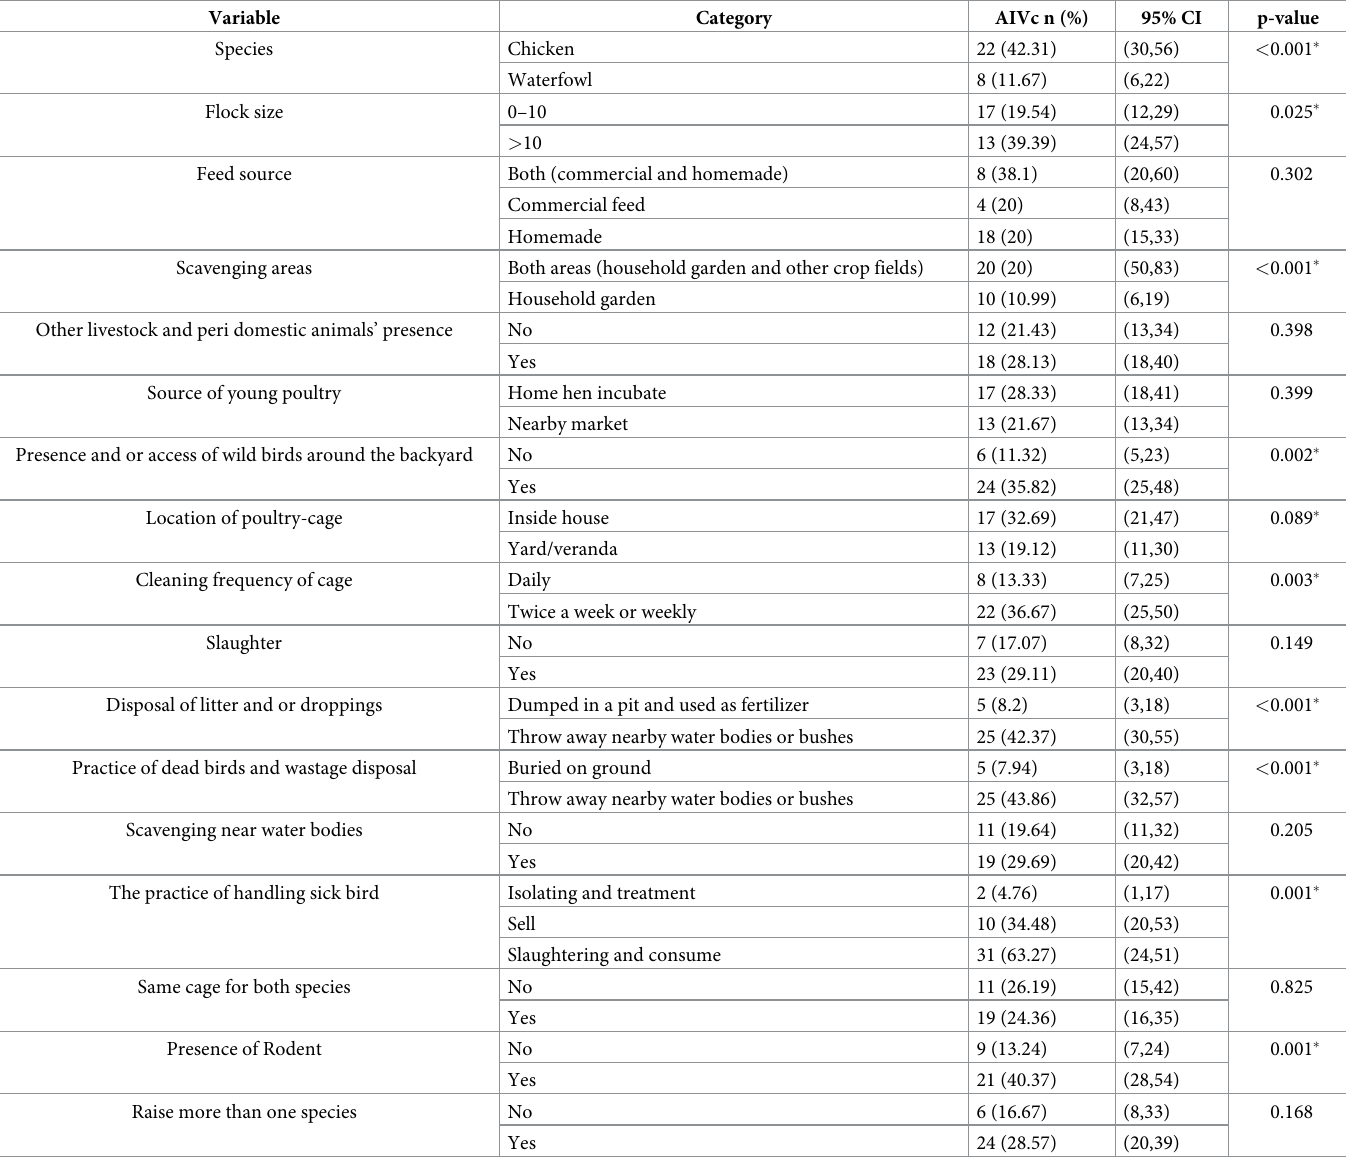
Table 1. Chicken and waterfowl rearing practices associated with Influenza A (Results to chi-square